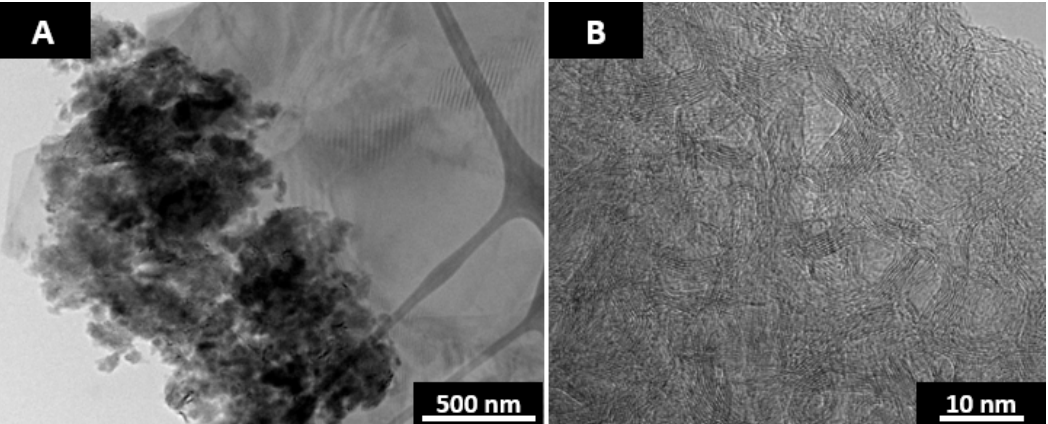
Figure 6. TEM micrographs of anthracene-fluorene coke—2600 °C, 1 h.